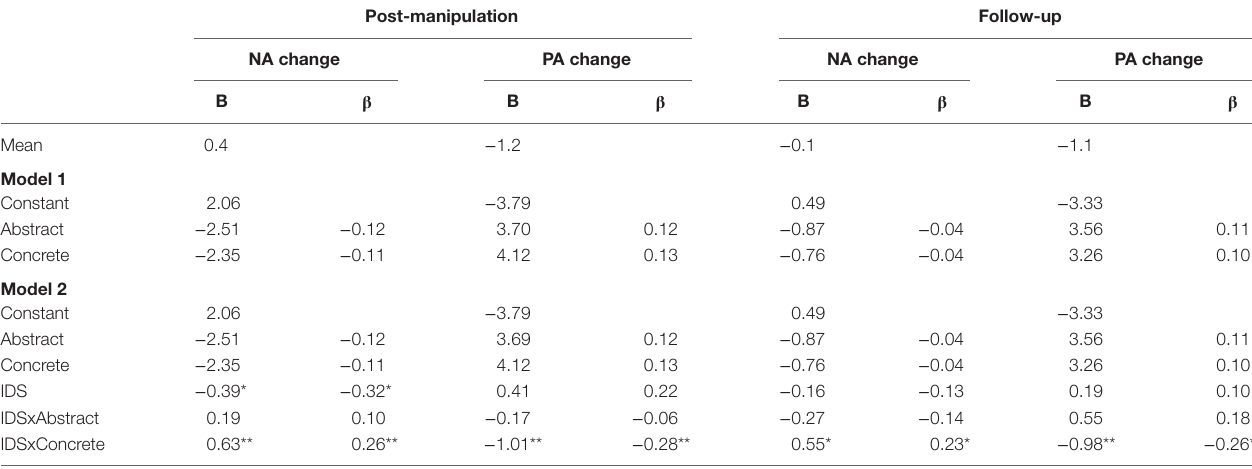
TaBle 3 | regression model summaries testing the causal role of processing mode on affective impact of recall and depressive symptomatology as moderator.